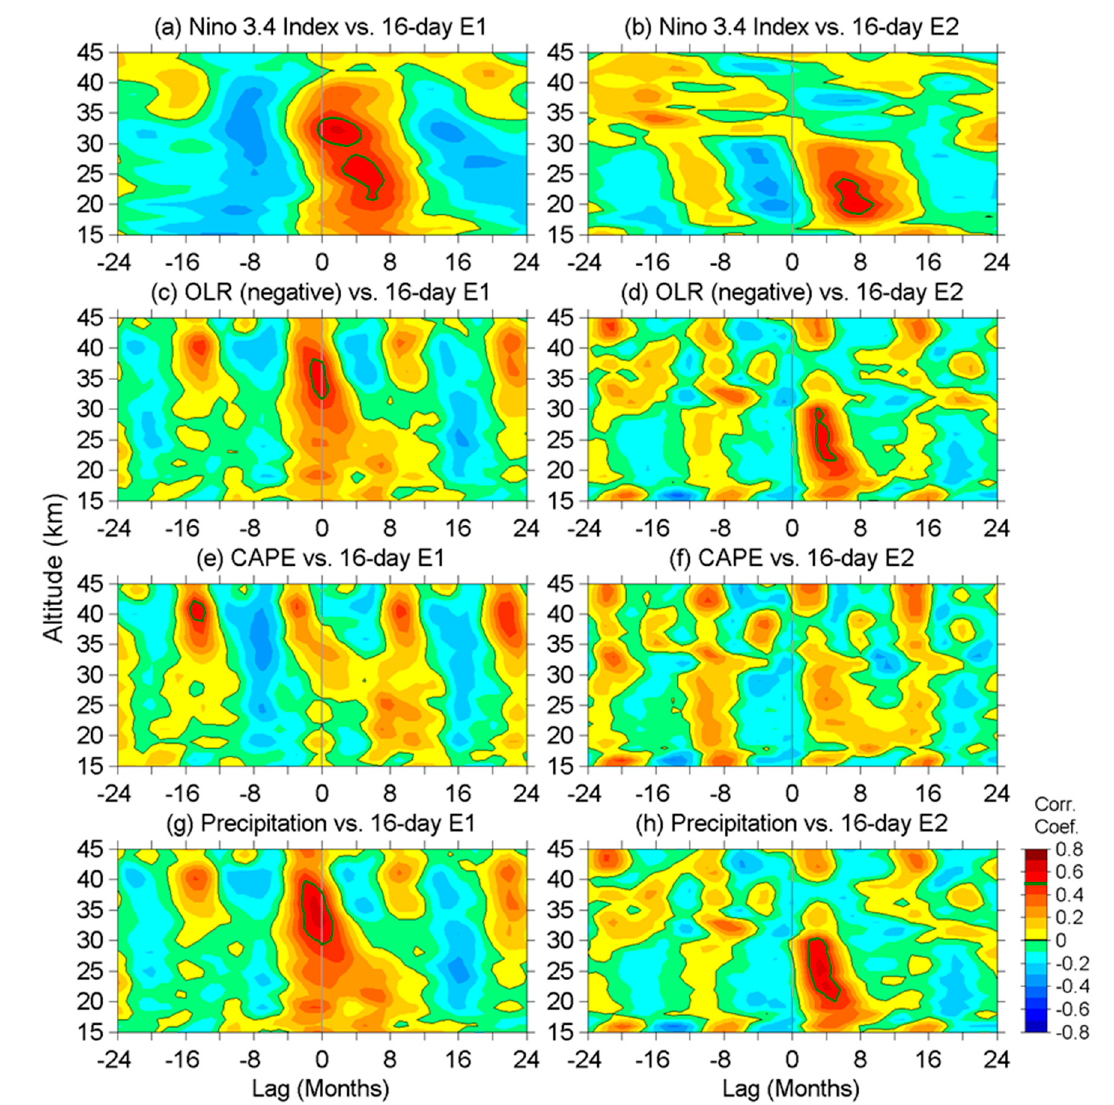
Figure 11. The linear cross correlation coe ffi cients between ( a , b ) the Niño 3.4 index; ( c , d ) OLR; ( e , f ) CAPE; ( g , h ) precipitation and the 16-day E1 / E2 amplitudes, respectively. Black and green lines circle regions where the correlation coe ffi cient is greater than 0 and 0.5, respectively. Gray lines indicate zero